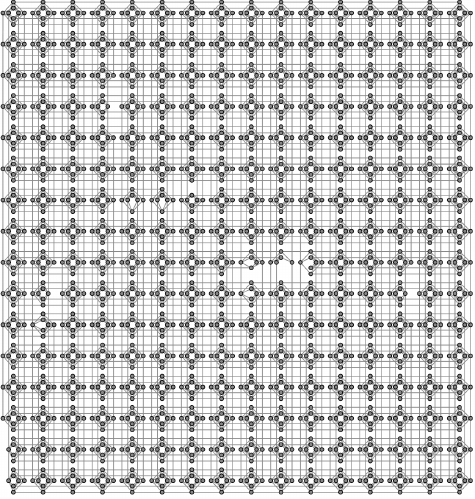
Figure 1. The hardware graph H of D-Wave 2000Q is a 12 × 12 array of unit cells, wherein each unit cell is a 4 × 4 bipartite graph. The depicted graph is the hardware connectivity graph of the D-Wave 2000Q machine at Los Alamos National Laboratory, showing a few of its qubits disabled due to hardware errors. The particular connectivity structure of the hardware graph is referred to as a Chimera graph